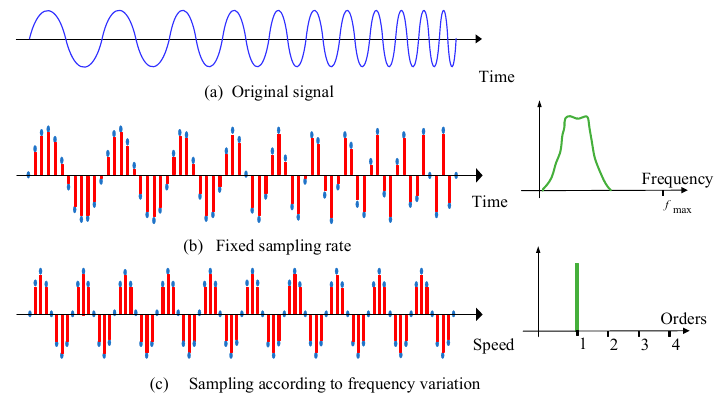
Figure 9. OT equal angular interval sampling.